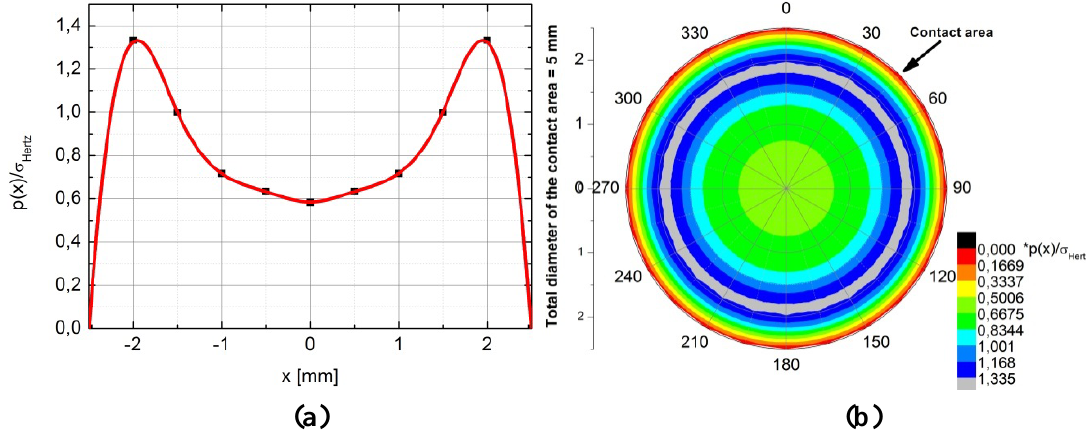
( a ) along a Hertz